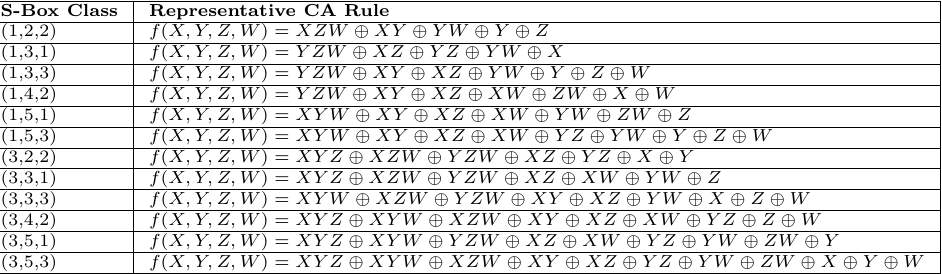
Table 1: Grouping S-Boxes into classes by ANF properties